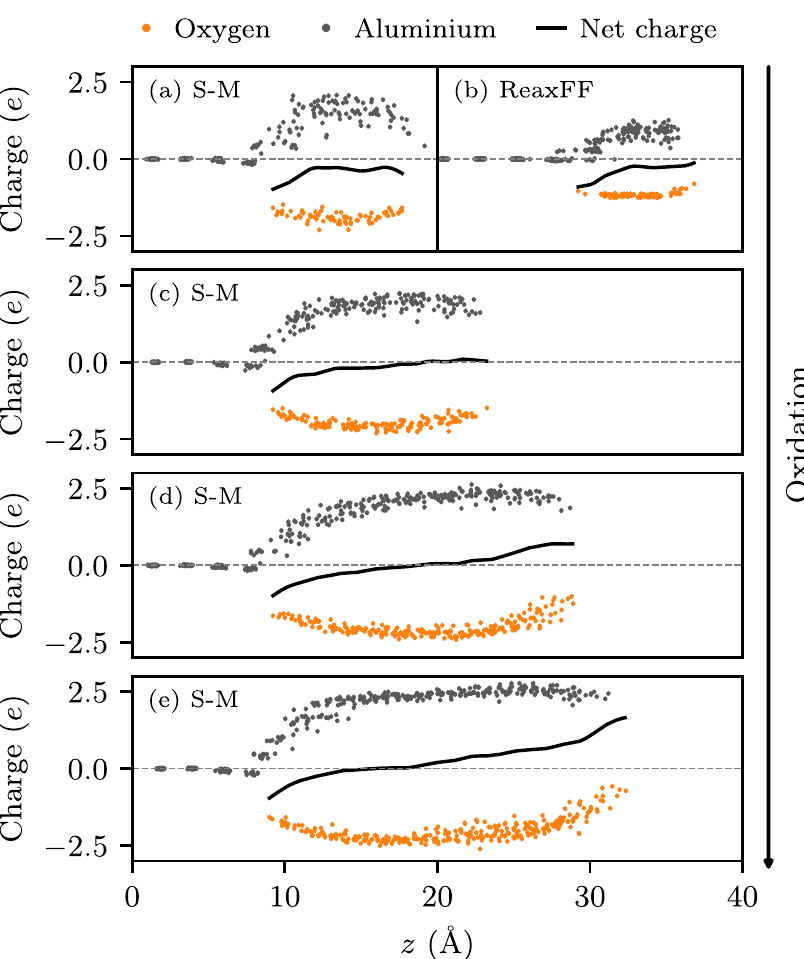
Fig. 7 Partial charges in the structure at varying stages of oxidation. The partial charges of oxygen and aluminium atoms are shown as orange and grey dots, respectively. The black lines show the net charge in the structure as a function of z . a , b A comparison between the S – M and ReaxFF potentials for a 1-nm-thick surface oxide. c – e The development of a charge gradient after continued oxidation using the S – M